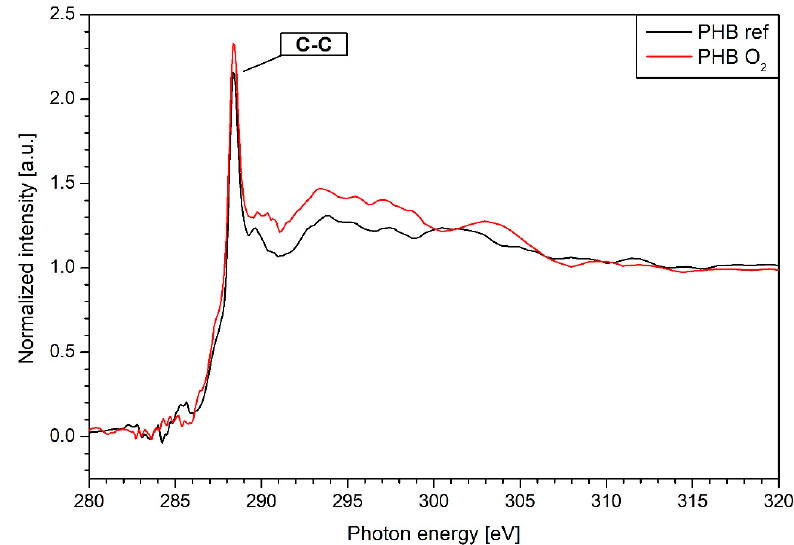
Figure 4. Near edge X-ray absorption fine structure (NEXAFS) spectra of a raw and untreated PHB (black) compared to an O 2 plasma treated one (red), which is used as the new reference for further analysis.